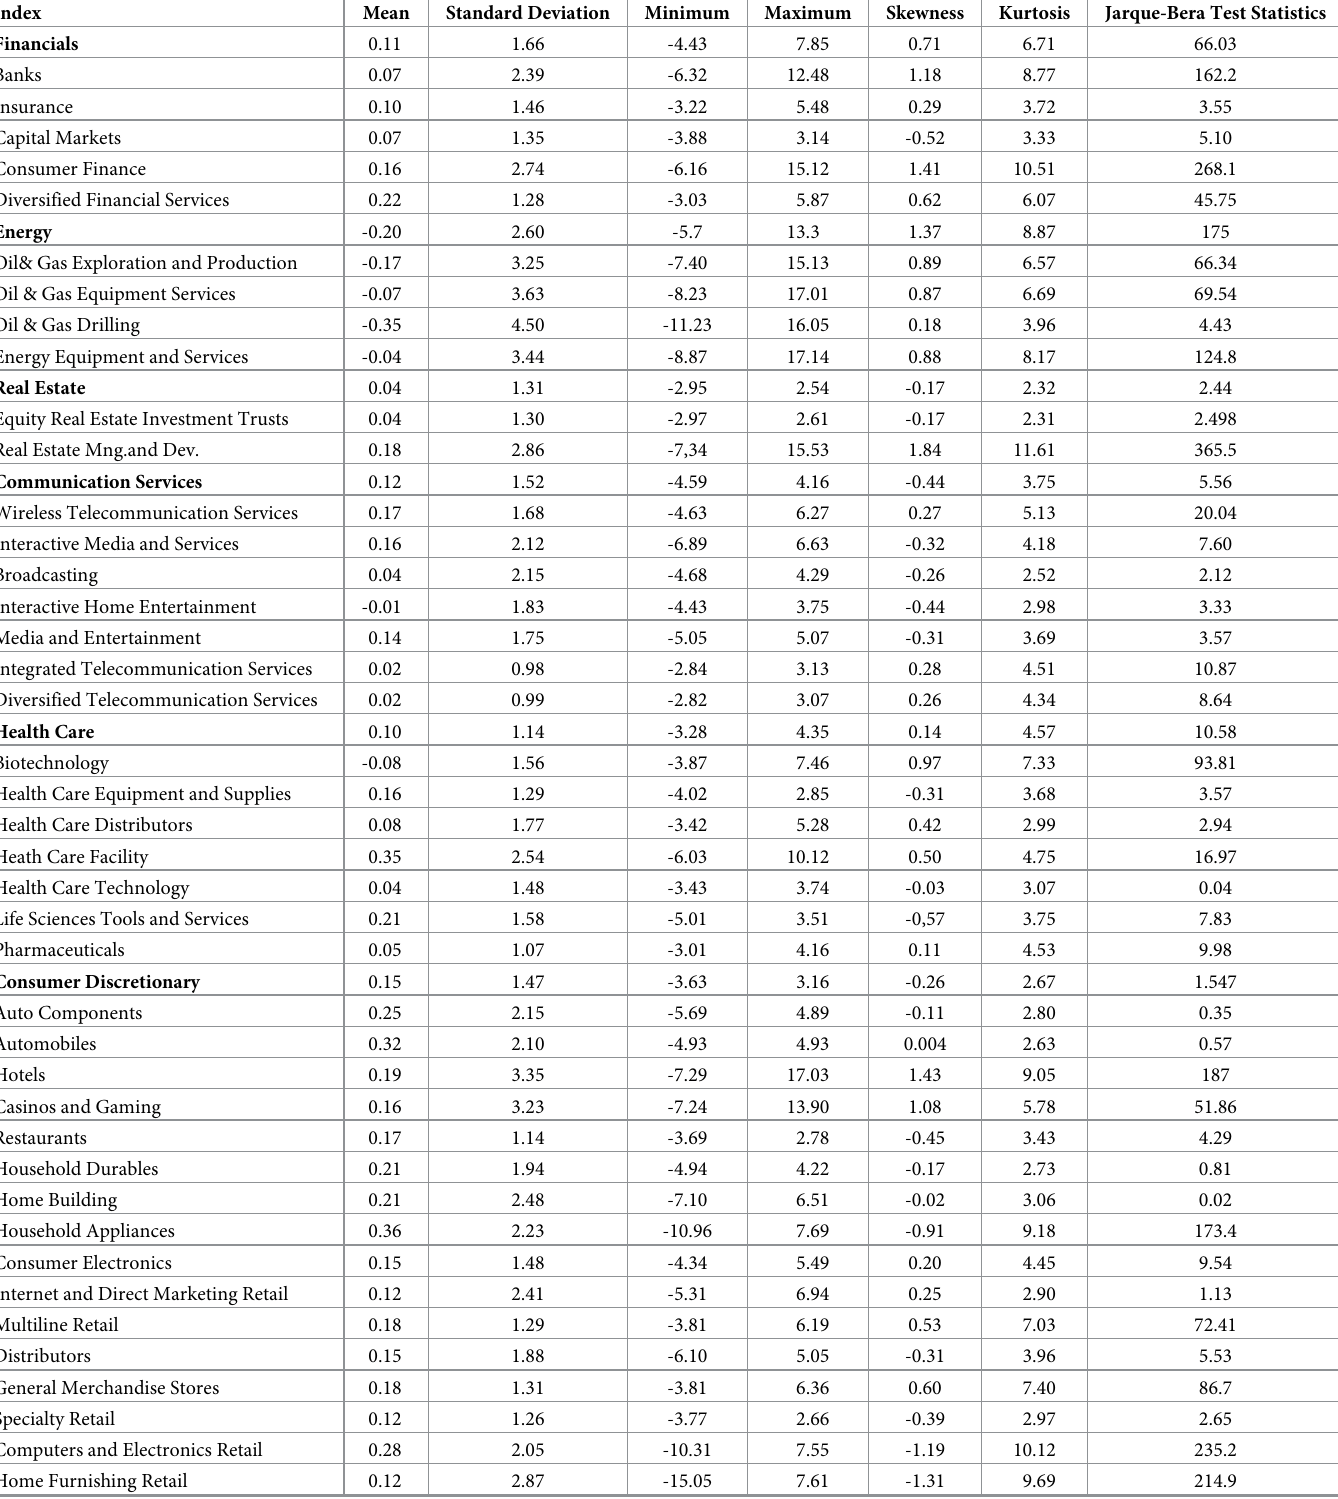
Table 1. Descriptive